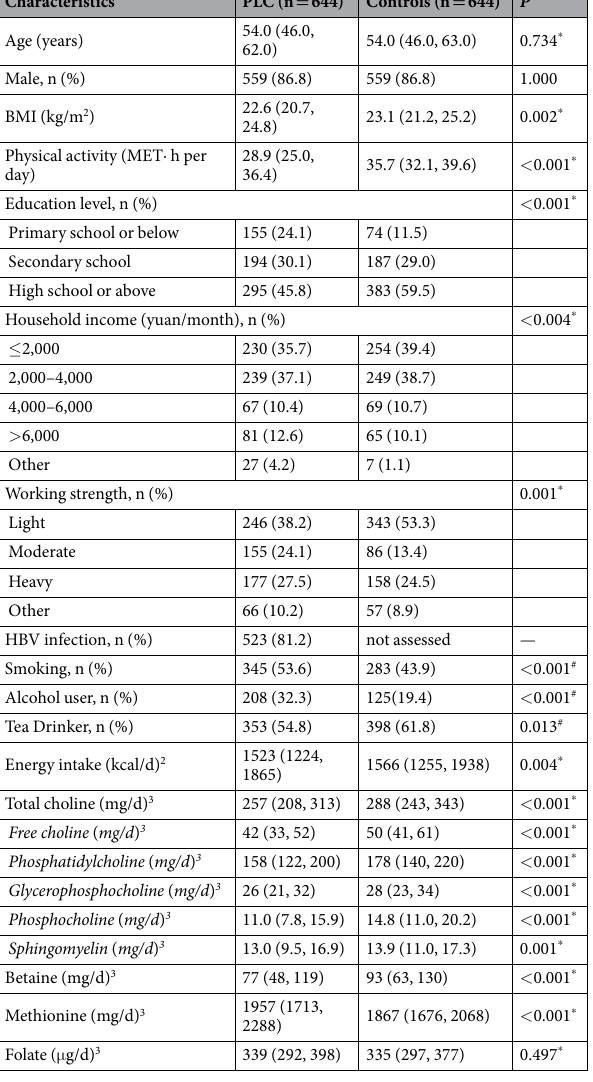
Table 1. Comparison of the general characteristics between primary liver cancer cases and controls 1 . 1 Continuous values are medians (P25, P75). 2 Energy intakes exclude cooking oil. 3 Energy-adjusted intake. * P values, Wilcoxon signed-rank test. # P values, McNemar’s test. Abbreviation: MET = metabolic